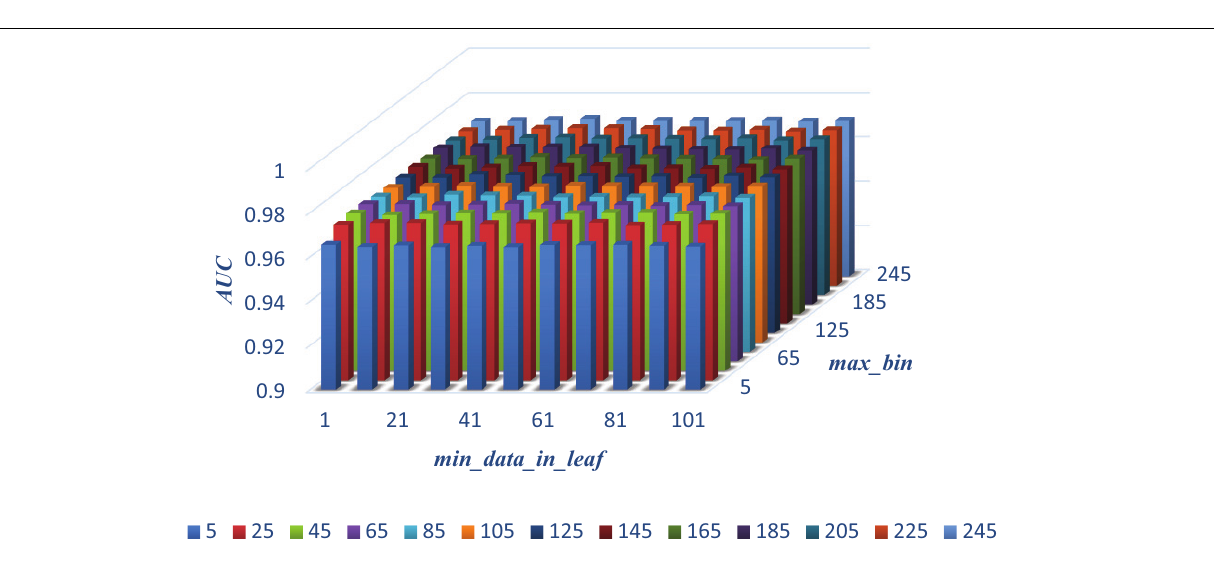
FIGURE 9 | The AUC values of different max_bin and